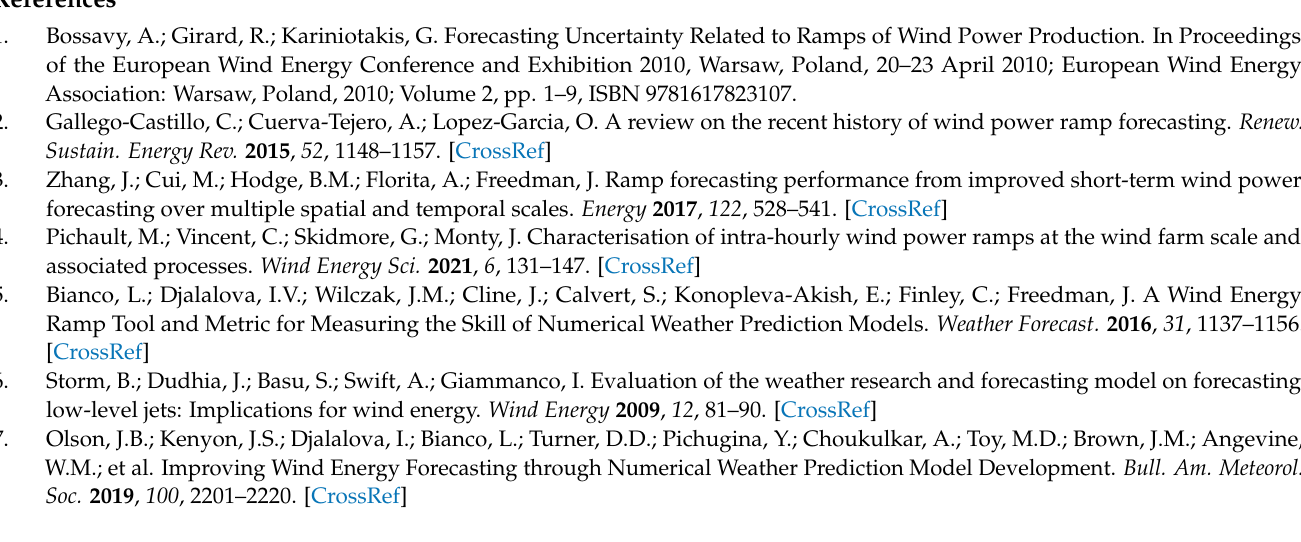
the track is indicated with a cross; Figure S8. Meteogram at CDCU for a storm at 00:00 Z 25 July 2013. Wind ramp timing is shaded in yellow. CMORPH maximum precipitation in the center of the storm is in blue bars. Estimated wind gust in the storm is in red line and observed wind gust at CDCU is in blue. Forecasted wind speed, wind vector and precipitation are in green; Figure S9. Meteogram at FCOV for a storm at 22:00 Z 03 July 2007. Wind ramp timing is shaded in yellow. CMORPH maximum precipitation in the center of the storm is in blue bars. Estimated wind gust in the storm is in red line and observed wind gust at FCOV is in blue. Forecasted wind speed, wind vector and precipitation are in green; Figure S10. Meteogram at LVEN for a storm at 18:00 Z 07 July 2003. Wind ramp timing is shaded in yellow. CMORPH maximum precipitation in the center of the storm is in blue bars. Observed wind gust at LVEN is in blue; Figure S11. Example of wind ramps. Wind ramp observed and predicted (TP), wind ramp predicted by NAM but not observed (FP), and wind ramp observed but not predicted by NAM (FN). Events occurred in different days; Table S1. List of abbreviations; Table S2. Derived contingency table indexes wind NAM forecast (non-corrected), bias corrected and quantile mapping (QM) corrected for CDCU; Table S3. Derived contingency